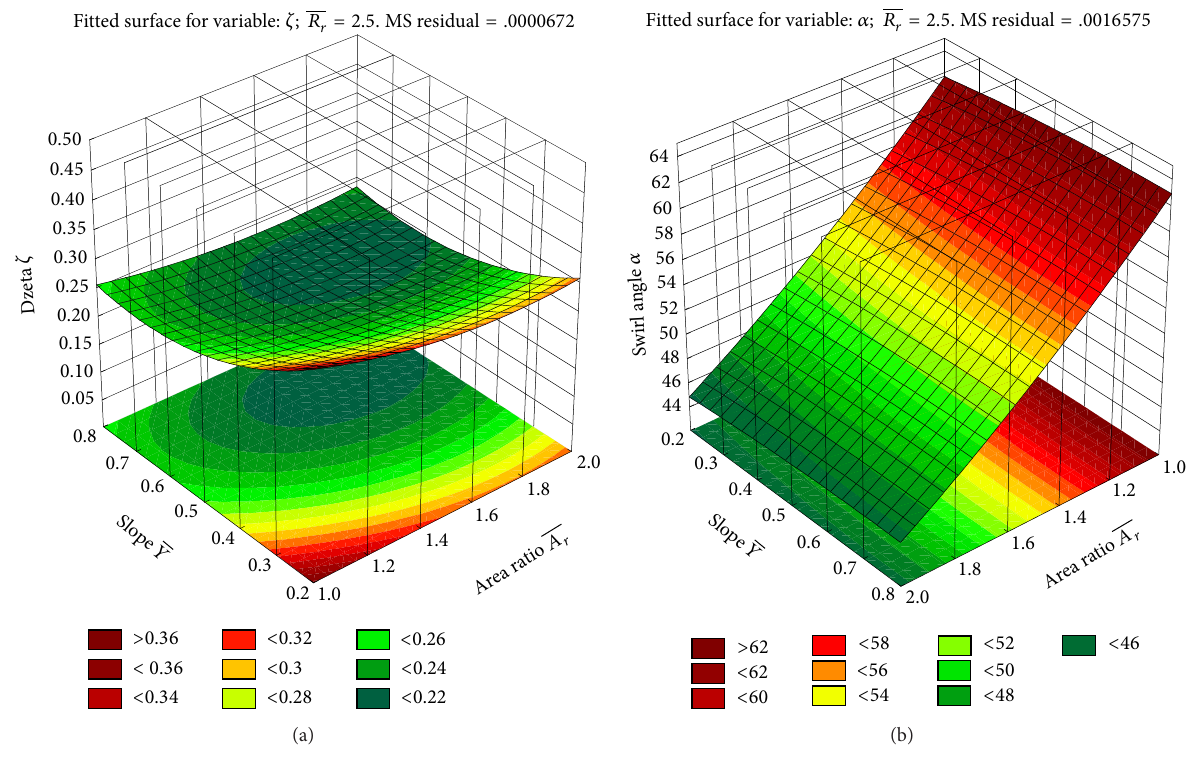
Figure 9: Response surfaces of output criteria 𝜁 (a) and 𝛼 1 (b) at 𝑅 𝑟 = 2.5 for 𝛼 0 = 45 ∘